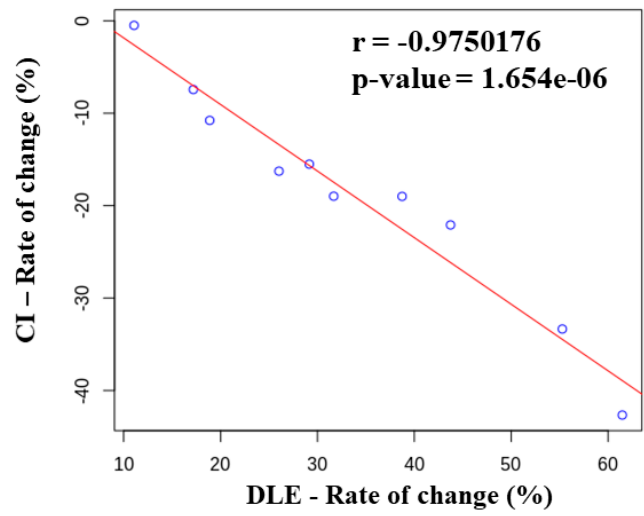
Figure 10. Correlation analysis between DLE Index and CI Index.